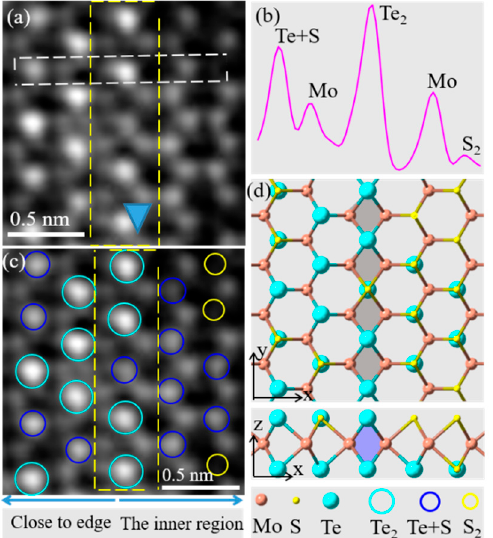
Figure 2. ( a ) A typical atomic resolution ADF-STEM image of the 4 | 4P-Te MTB with its atomic model shown in ( d ), in which the top image is the top view of the atomic model, and the bottom is the side view. ( b ) The intensity profile along white dashed lines in ( a ). ( c ) The spatial distribution of doped tellurium.